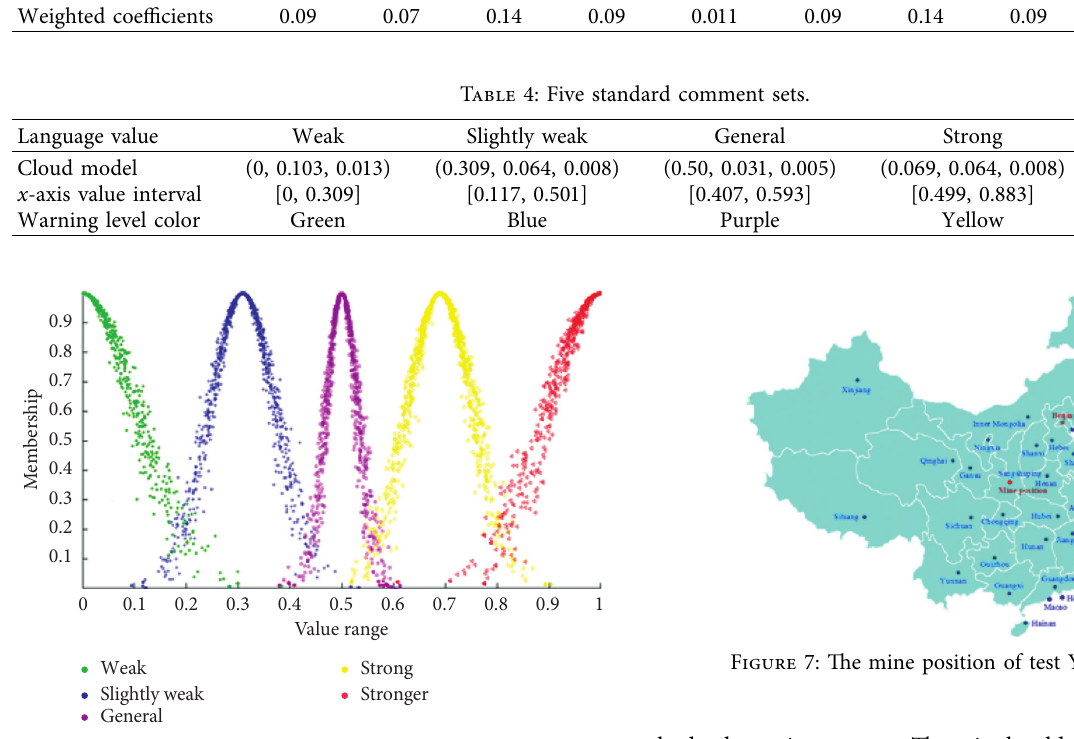
Figure 6: Standard evaluation cloud model.